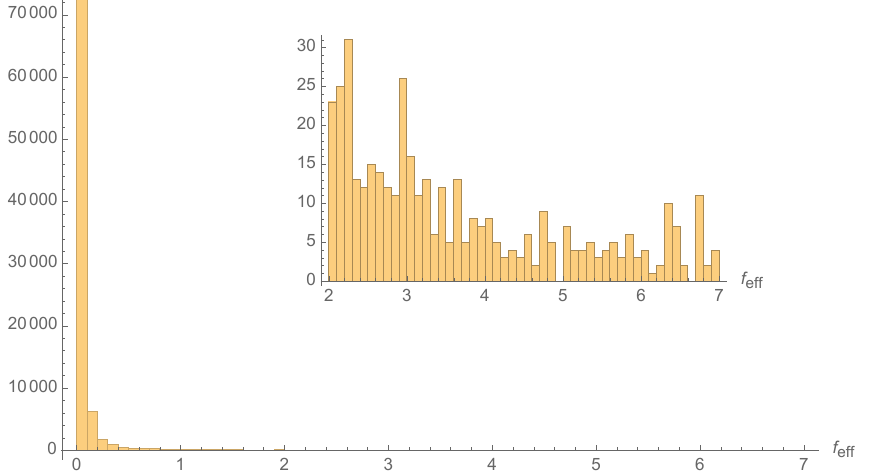
Figure 6 . Distribution of effective decay constants in units of the Planck mass, from 100,000 samples. We assume a uniform distribution of quadruples ( Q 11 , Q 12 , Q 21 , Q 22 ) as above. We take the volume and parameters as in the second row of table 2. The inner panel provides a zoomed-in view of the range 2 ≤ f eff ≤ 7